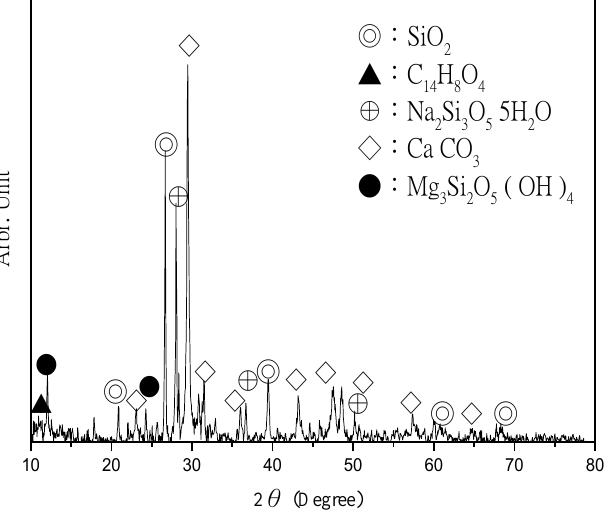
Figure 6. XRD of acicular-structured